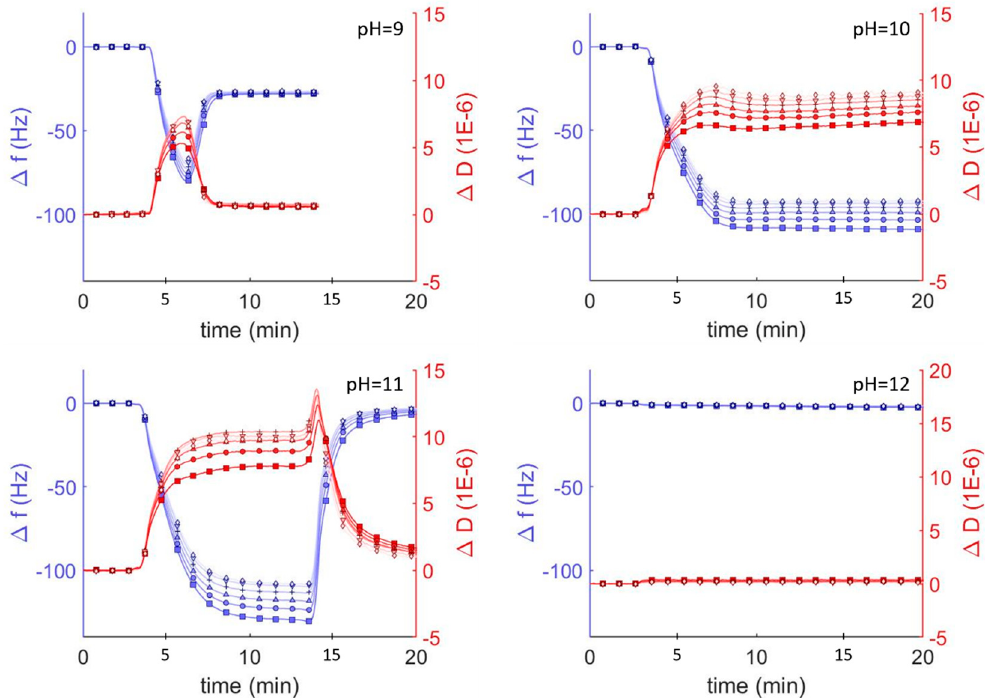
Figure 2. QCM-D monitoring of overtone normalized frequency change ( Δ f/n ; blue traces and axes) and dissipation changes ( Δ D ; shown in red ) for lipid vesicles interacting with plasma cleaned borosilicate glass. After establishing a baseline buffer solution measurement, vesicles composed of DOPC (0.1 mg mL − 1 ) in Tris buffer at varying pH were injected into the QCM module. Showing the 3rd through 13th overtones, 3rd ( □ ), 5th ( ○ ), 7th ( ∆ ), 9th (+), 11th (inverted triangles), 13th ( ◊ ).